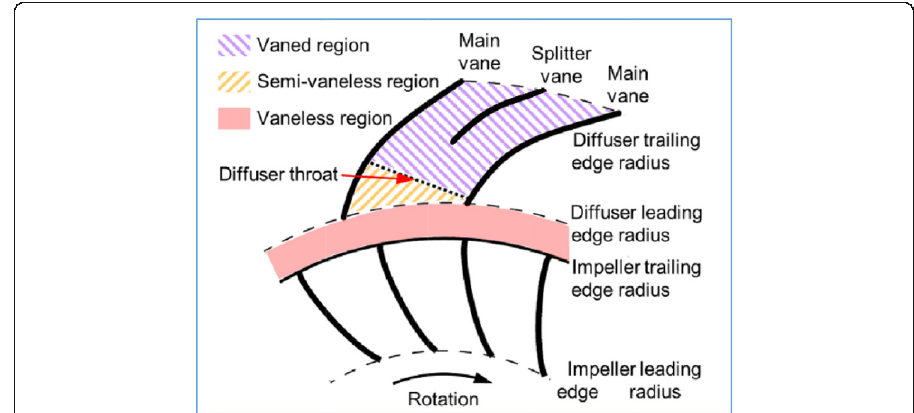
Fig. 2 Schematic of the diffuser